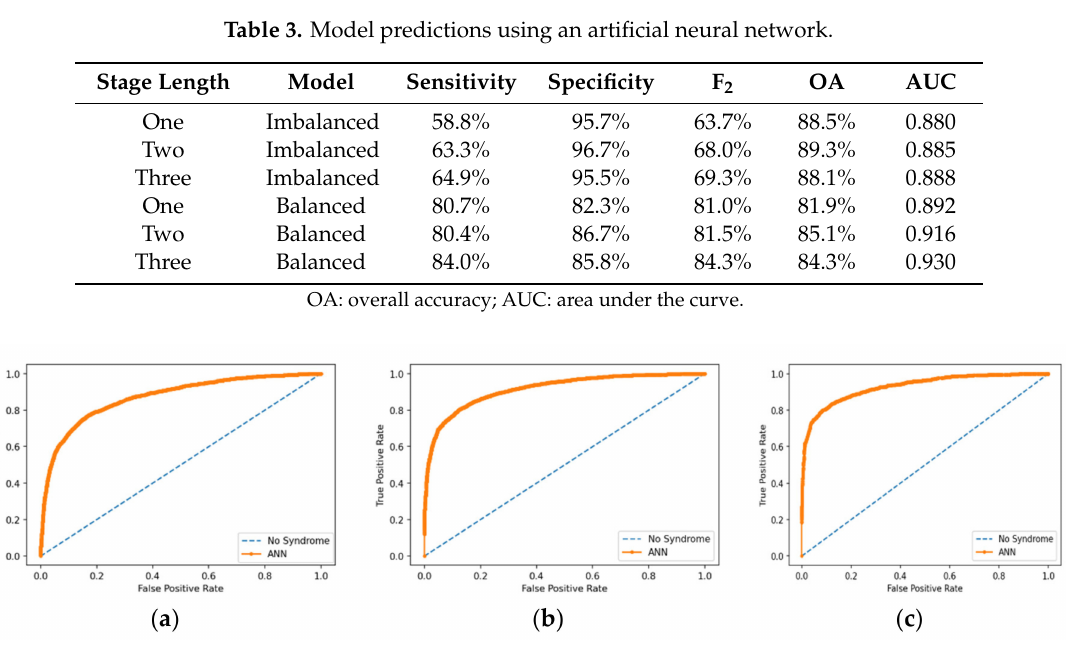
Figure 1. ( a ) AUC / receiver operating characteristic (ROC) curve of the balanced one-stage model; ( b ) AUC / ROC curve of the balanced two-stage model; ( c ) AUC / ROC curve of the balanced three-stage